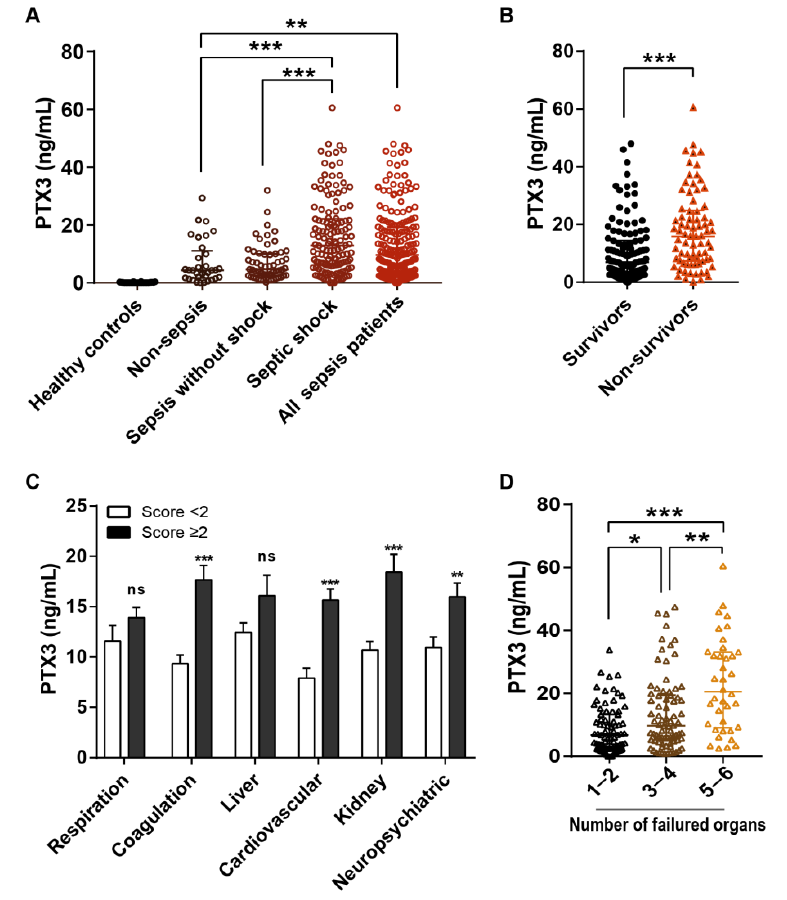
Figure 2. Pentraxin-3(PTX3) levels and demographics. These panels show the existing differences in serum levels of PTX3 in ICU patients by selected demographics. PTX3 levels were higher in sepsis and septic shock patients ( A ), in non-survivors with 90-day ( B ), in patients with sub-SOFA score > 2 ( C ), and in patients with more failure organs ( D ). Concentrations of PTX3 were measured by ELISAs. Data are presented as the median and interquartile range (Mann – Whitney U test or Kruskal – Wallis test, respectively). * p < 0.05, ** p < 0.01, *** p < 0.001, Here “ns” means “ not